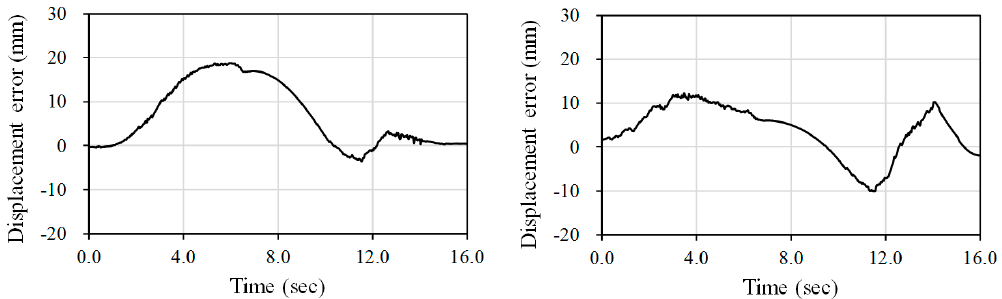
Figure 6. Displacement errors for x -direction ( left ) and y-direction ( right ).